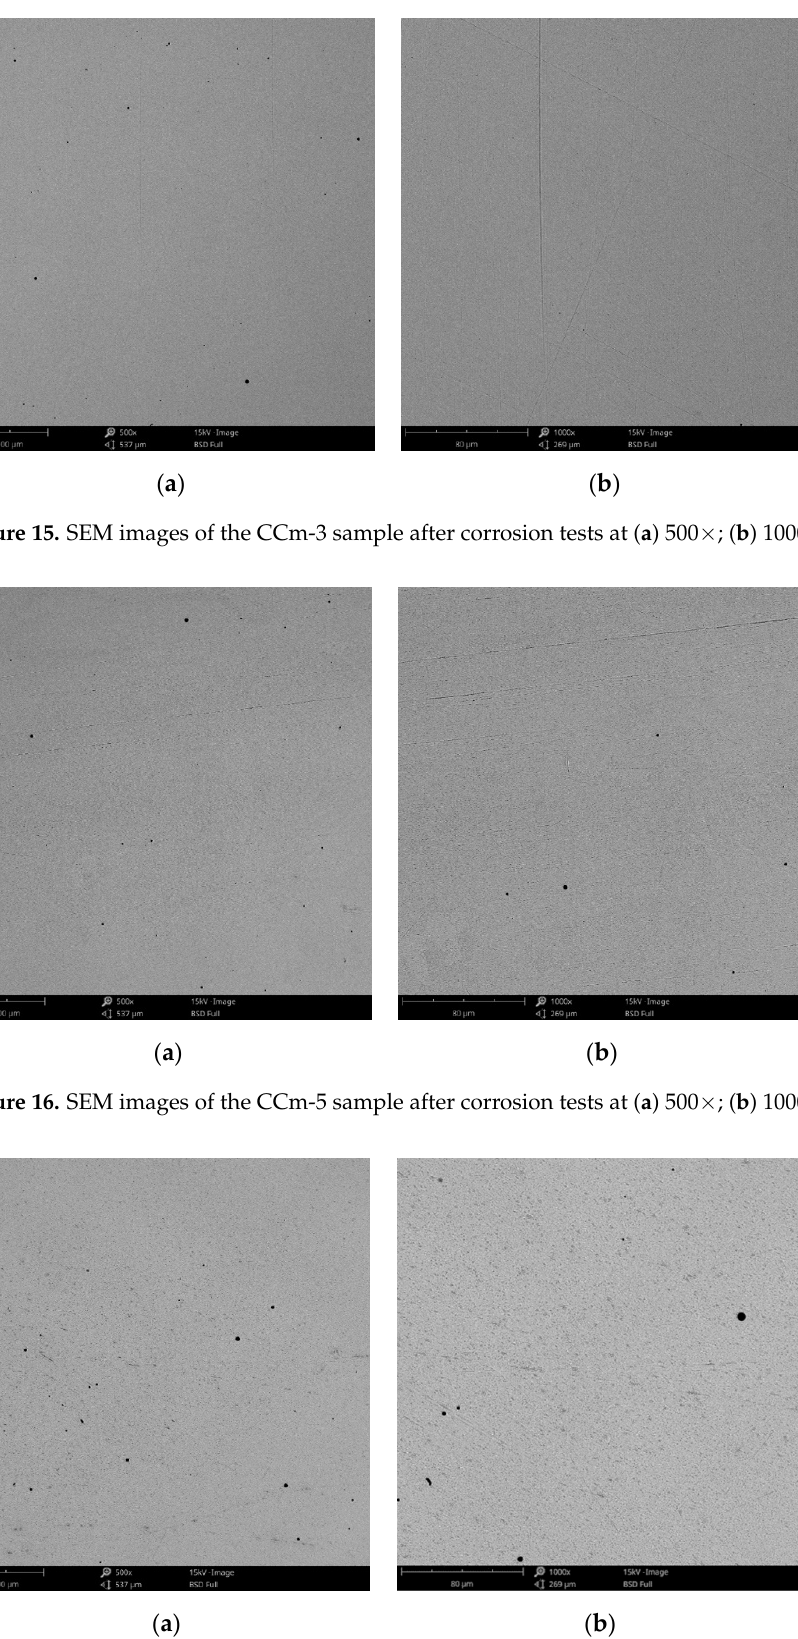
Figure 14. SEM images of the CCc-7 sample after corrosion tests at ( a ) 300×; ( b ) 500×.